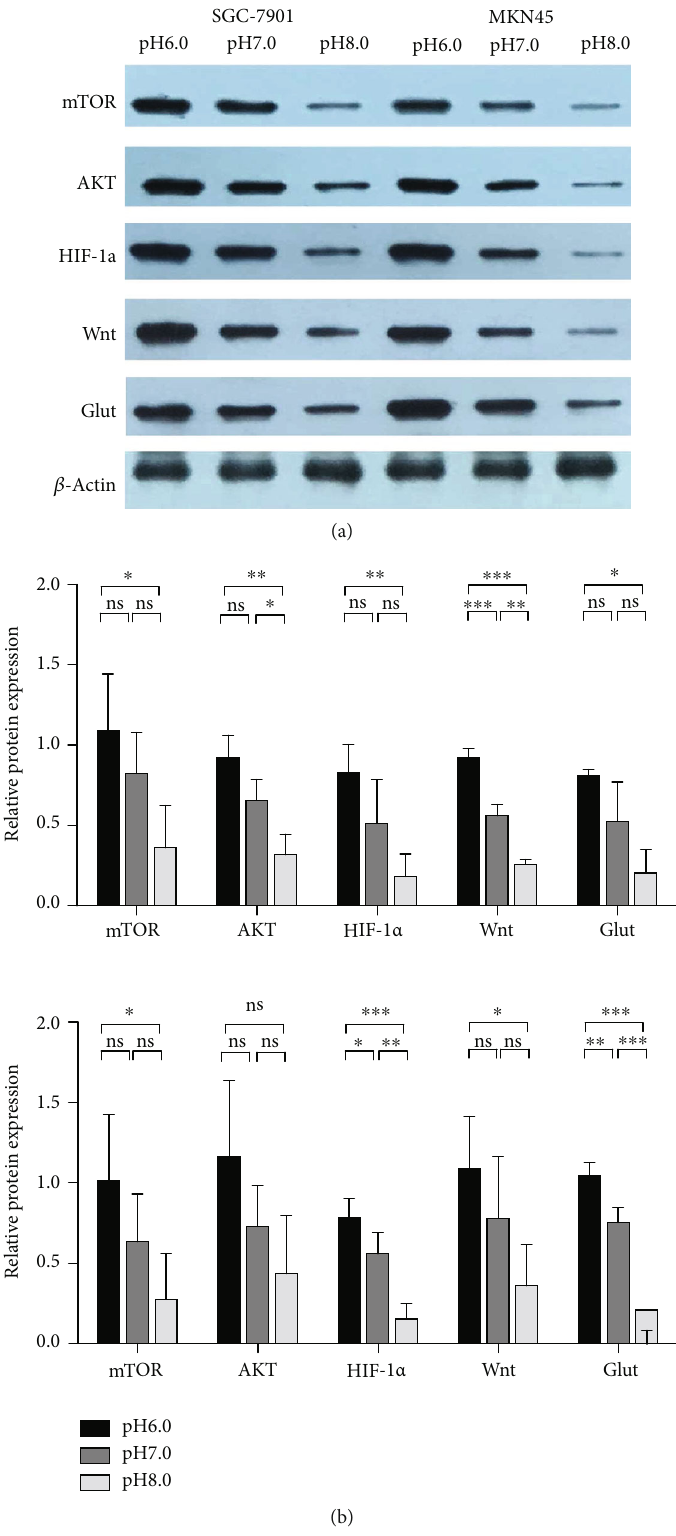
Figure 5: Alkaline microenvironment inhibited the expression of proteins (mTOR, AKT, HIF-1 α , Wnt, and Glut). (a) Grayscale analysis of WB bands. (b) WB detected the expression of proteins (mTOR, AKT, HIF-1 α , Wnt, and Glut) in GC cells (SGC-7901 and MKN45) at di ff erent pH values (pH 6.0, pH7.0, and pH 8.0) after being cultured for 48